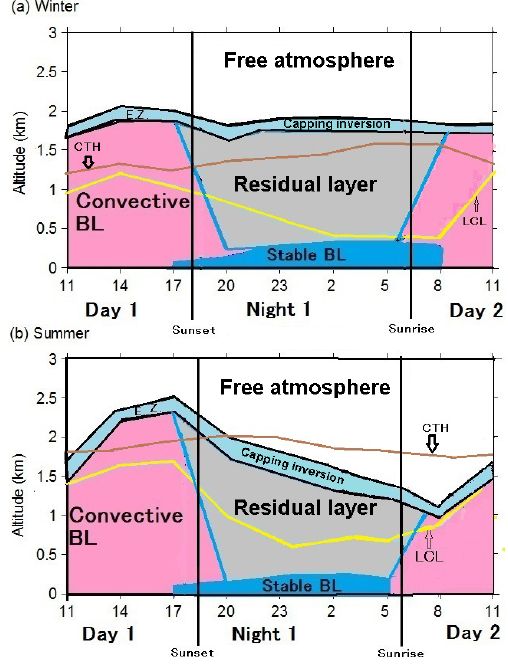
Figure 12. Schematic diagram of the vertical cross section of the mean ABL structure along with LCL and CTH during the (a) winter (DJF) and (b) summer monsoon (JJA) seasons over Gadanki. E.Z. indicates entrainment